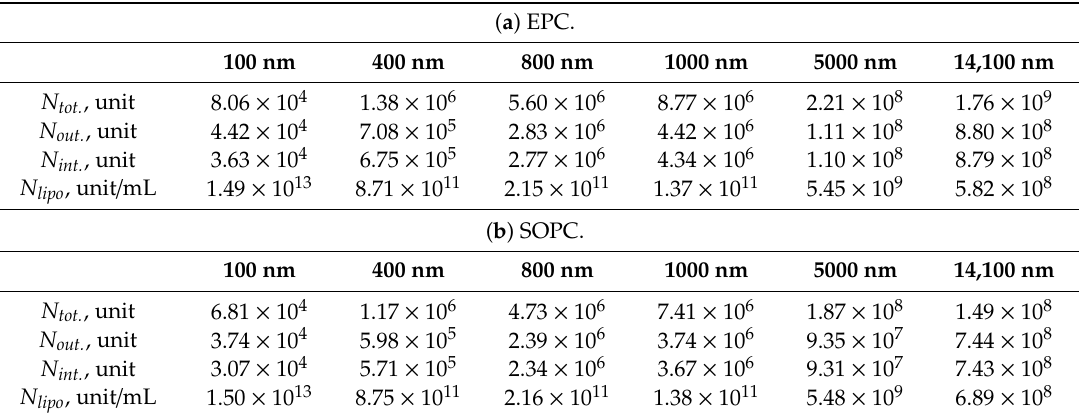
Table 1. Geometrical parameters of vesicles.